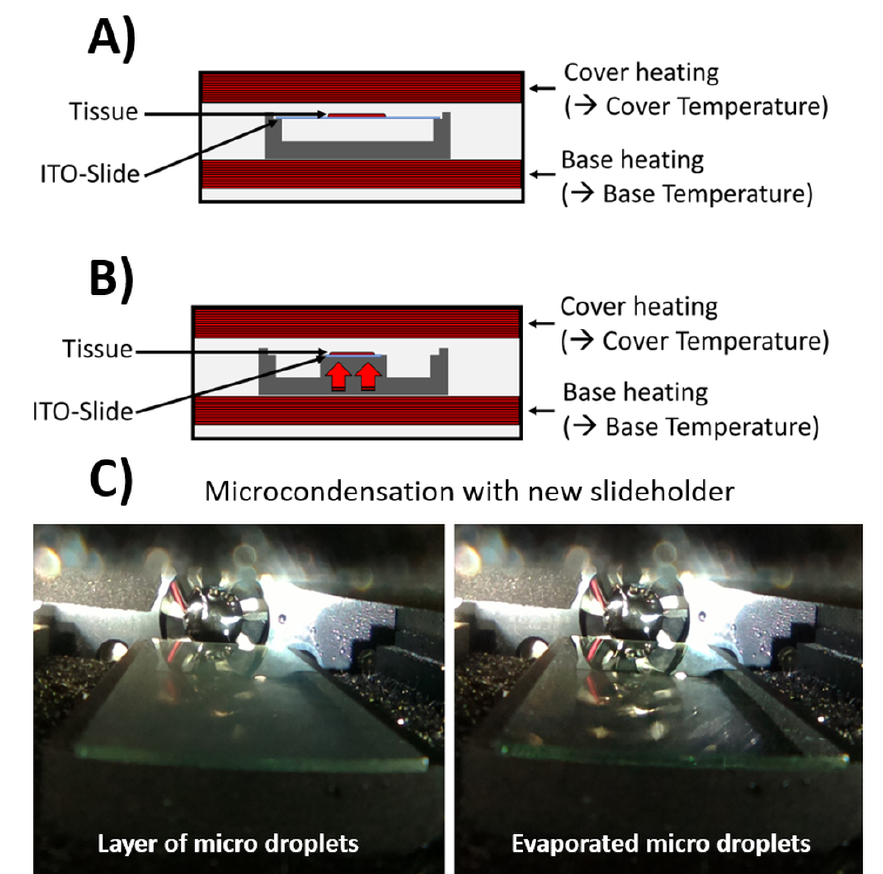
Figure 3. Design of the digestion chamber for controlled condensation of microdroplets on tissue slices on ITO slides . In contrast to an ( A ) old design of a digestion chamber, ( B ) a heated slide holder was constructed for this computer-controlled device that allows for direct and fast regulation of the base temperature of the ITO-slide. ( C ) Periodic temperature cycling results in slides covered with a thin, homogenous layer of condensed microdroplets (left panel), which evaporate when the base temperature is increased again (right